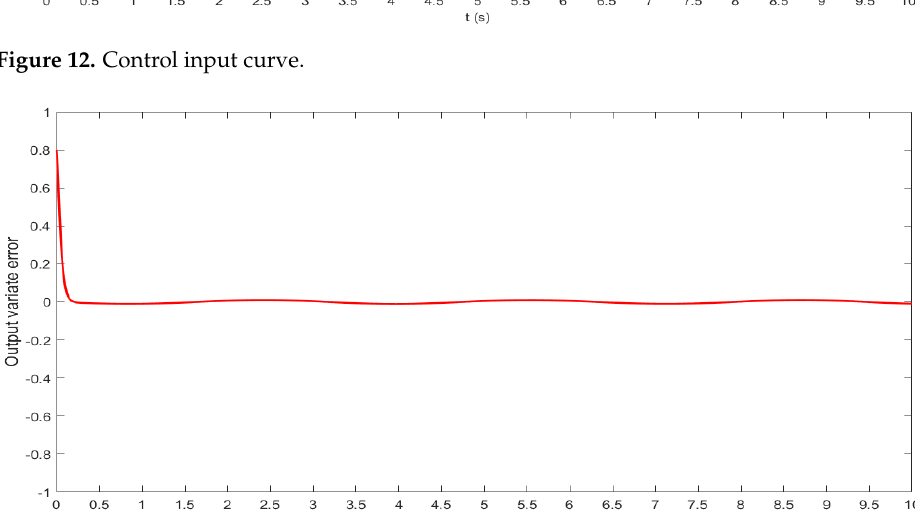
Figure 13. Output error curve.